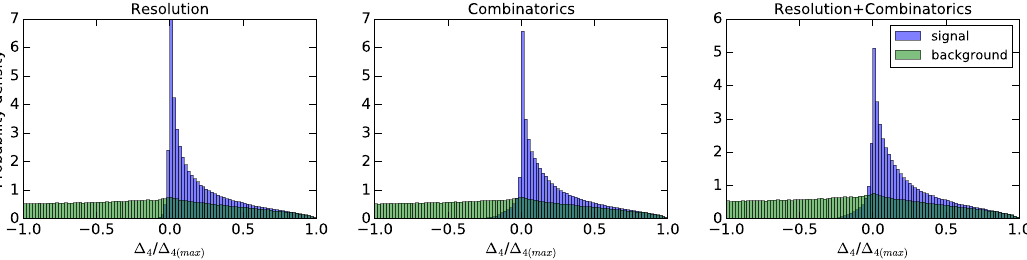
Figure 5 . The (cid:1) 4 histograms for signal (blue) and (uniformly distributed) background (green), with energy resolution and combinatoric ambiguities included. To be compared to (cid:12)gure 3 distribution in m 2 and m 2 , and a nearly (cid:13)at distribution in m 2 as well. This explains 12 23 13 the near-(cid:13)atness of the S/B performance curves of the m 2 variables, as well as the p N bins ij scaling for the S = p B performance curves. As can be seen from the (cid:12)gures, (cid:1) performs 4 signi(cid:12)cantly better than these with respect to both